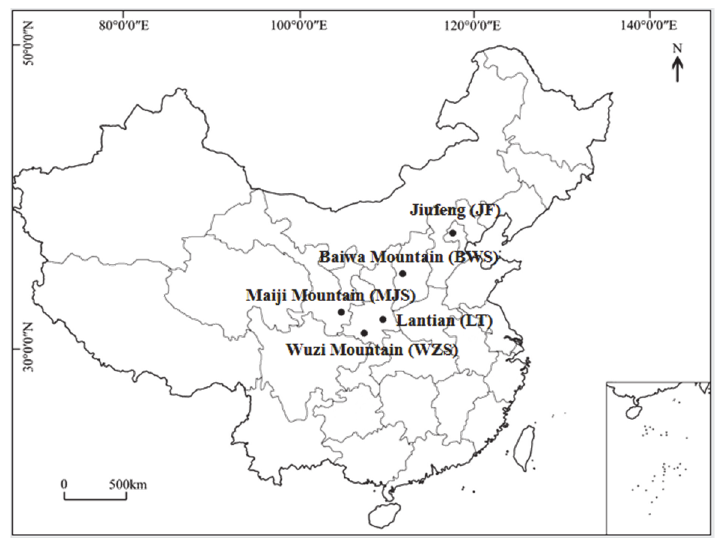
Figure 1. Geographical distribution of the studied P. bungeana populations.